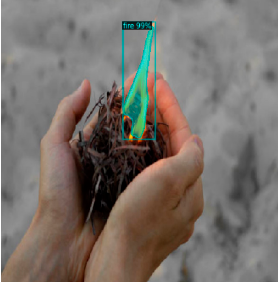
Figure 11. Small-size fire detection.